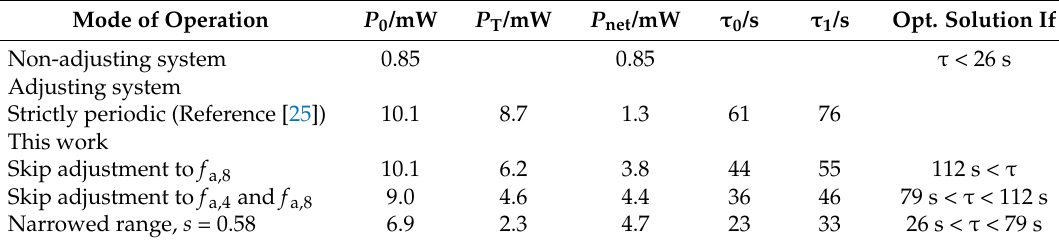
Figure 13. The available power for various operating modes of the self-adaptive harvester from Ref. [25]. Table 1. Powers (@ τ = 70 s) and minimum process stationarity times τ 0 , τ 1 for various operating modes of the self-adaptive harvester from Ref. [25].